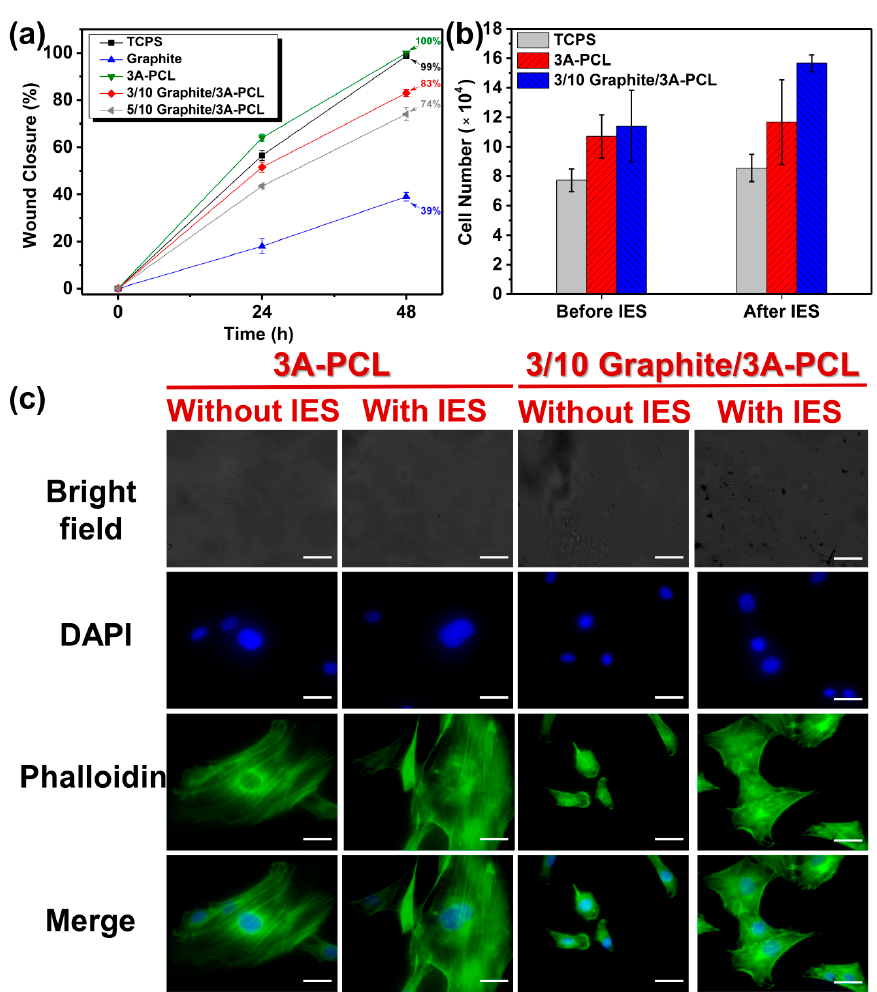
Figure 5. ( a ) The healing rate (percentage) of NIH/3T3 cells by scratch wound healing assay cul- tured on TCPS, 3A-PCL, 3/10, and 5/10 graphite/3A-PCL substrates at 0, 24, and 48 h after scratching. The ( b ) numbers and ( c ) CLSM images of NIH/3T3 cells harvested on TCPS, 3A-PCL and graphite/3A-PCL substrates treated with or without IES at 0.1 V for 24 h. White scale bars in ( c ) are 20 μ m in all images.